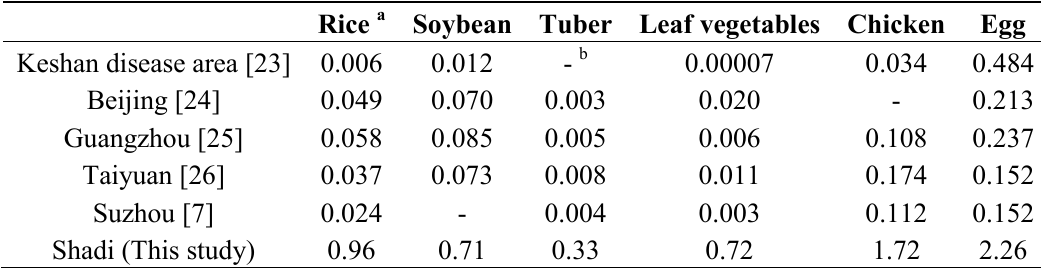
Table 2. Concentrations of selenium in different foods produced in different regions of China (mg kg −1 , wet weight).